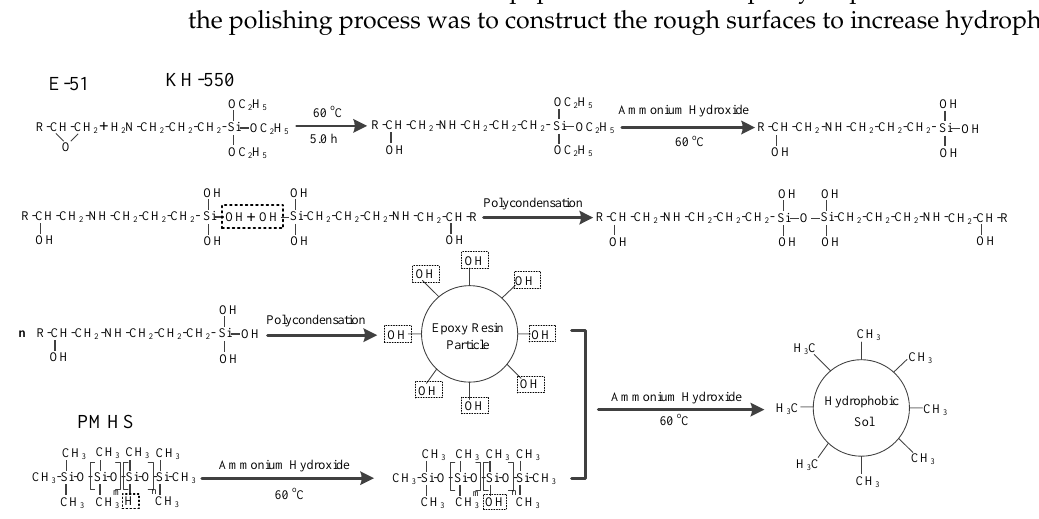
Figure 1. Synthetic reaction scheme of the hydrophobic gel.